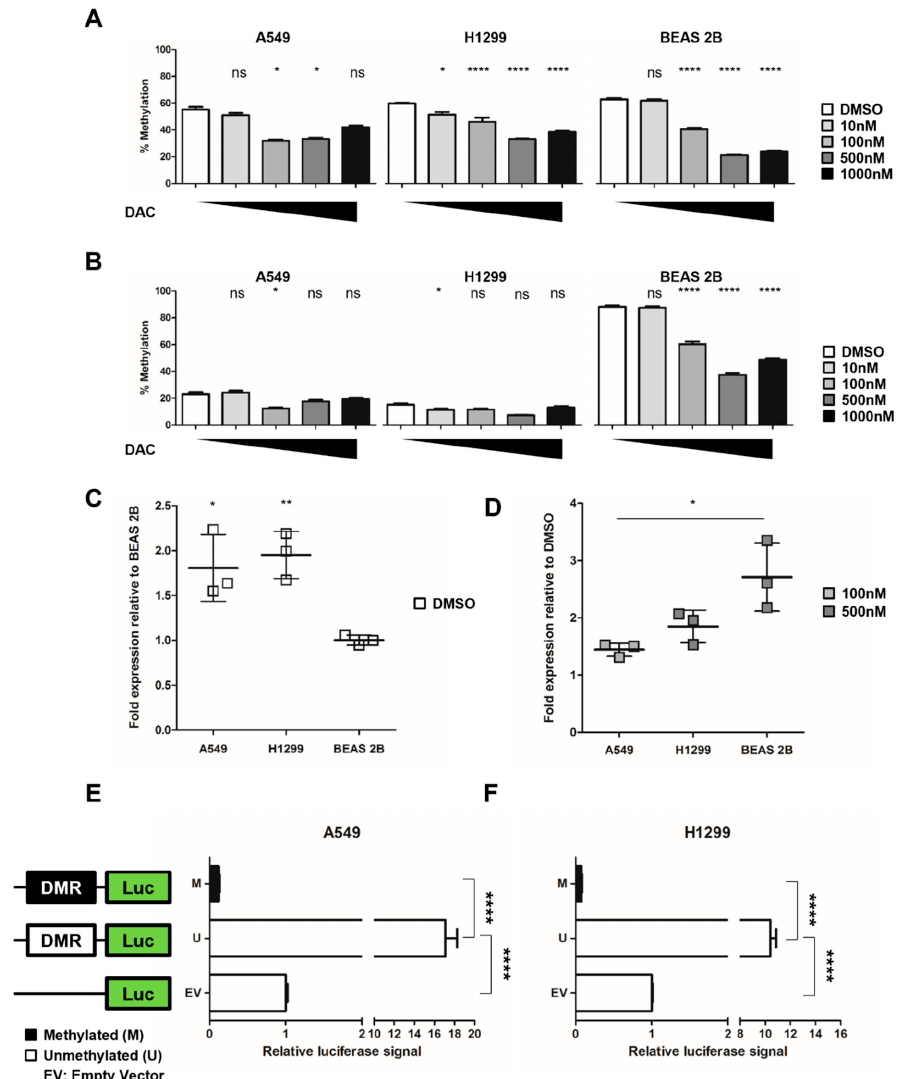
Figure 3. DMR regulatory potential for NHLRC1 mRNA transcription in lung cancer cell lines. ( A , B ) Left and middle graphs: DNA methylation levels after 72 h treatments with 5-Aza-2’-Deoxycytidine (DAC) of A549 (left) and H1299 (middle) lung cancer cell lines. Right graphs: DNA methylation levels after 96 h DAC treatments of normal bronchial BEAS 2B cells. White bars = DMSO-treated cells. ( A ) LINE1 DNA methylation in DMSO-treated versus DAC-treated cells, determined by BS conversion followed by pyrosequencing. Bars represent the mean DNA methyla- tion levels of 3 adjacent CpGs at the indicated DAC concentration. ( B ) NHLRC1 DNA methylation pyrosequencing in DMSO versus DAC treated cells. Each bar represents the mean DNA methylation levels of cg06646708 and 4 adjacent CpGs at the indicated DAC concentration. ( C ) Baseline NHLRC1 expression by real-time PCR in DMSO-treated cells relative to BEAS 2B ( D ) NHLRC1 gene expression real-time PCR in DMSO versus 500 nM (H1299, BEAS 2B) and 100 nM (A549) DAC-treated cells. ( E , F ) Dual luciferase assays of NHLRC1 upstream DMR region: ( E ) A549 cells, ( F ) H1299 cells. Fold luciferase activities induced by NHLRC1 upstream DMR unmethylated (U) or in vitro methylated (M) sequence relative to empty vector (EV) are displayed. Two-tailed t -test p -values, *: p < 0.05, **: p < 0.01, ****: p < 0.0001, ns: not